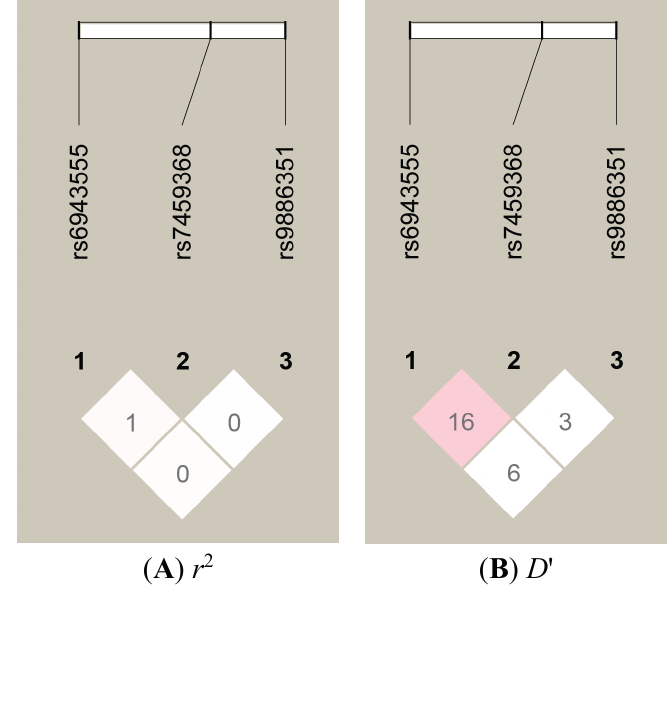
Figure 1. Linkage disequilibrium (LD) plots of the three single-nucleotide polymorphisms (SNPs) of the autism susceptibility candidate 2 ( AUTS2 ) gene. The values in the squares are the pair-wise calculations of r 2 ( A ) or D ' ( B ). The white squares with the “0” indicate r 2 = 0 ( i.e. , No LD between a pair of SNPs). The white squares with the “16” indicate D ' = 0.16 ( i.e. , very low LD between a pair of